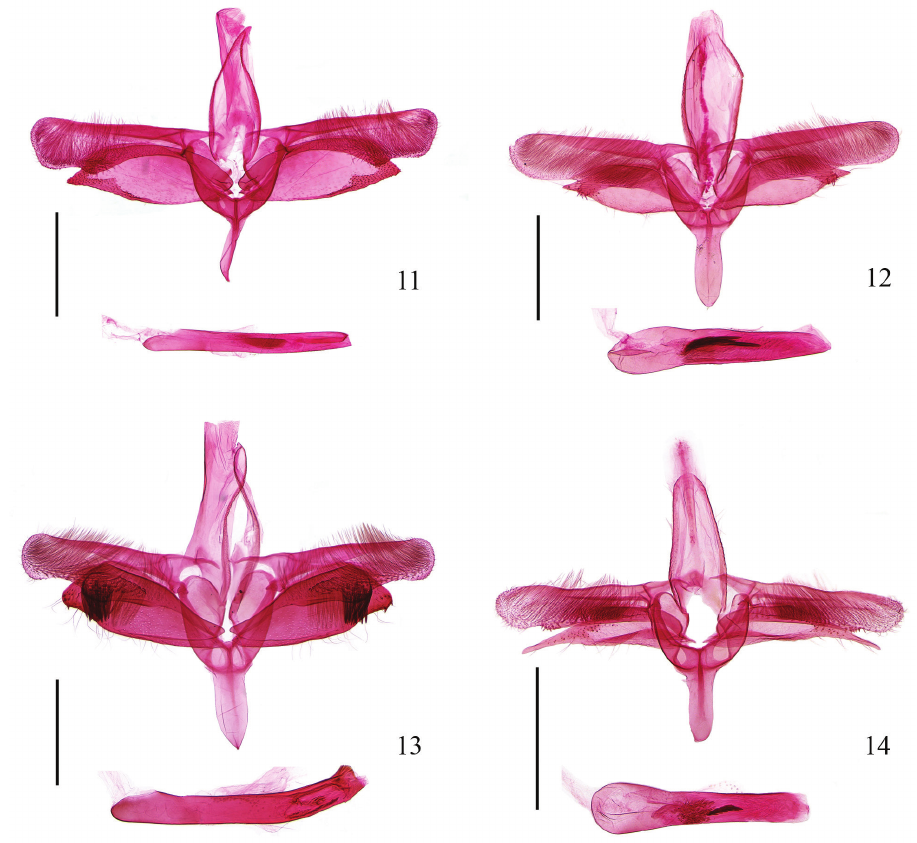
Figures 11–14. Male genitalia of Epicephala spp. 11 E. domina sp. n., holotype, genitalia slide No. WZB14337 12 E. impolliniferens sp. n., paratype, genitalia slide No. WZB14278 13 E. camurella sp. n., holotype, genitalia slide No. WZB14043 14 E. angustisaccula sp. n., paratype, genitalia slide No. WZB14001. Scale bar = 0.5